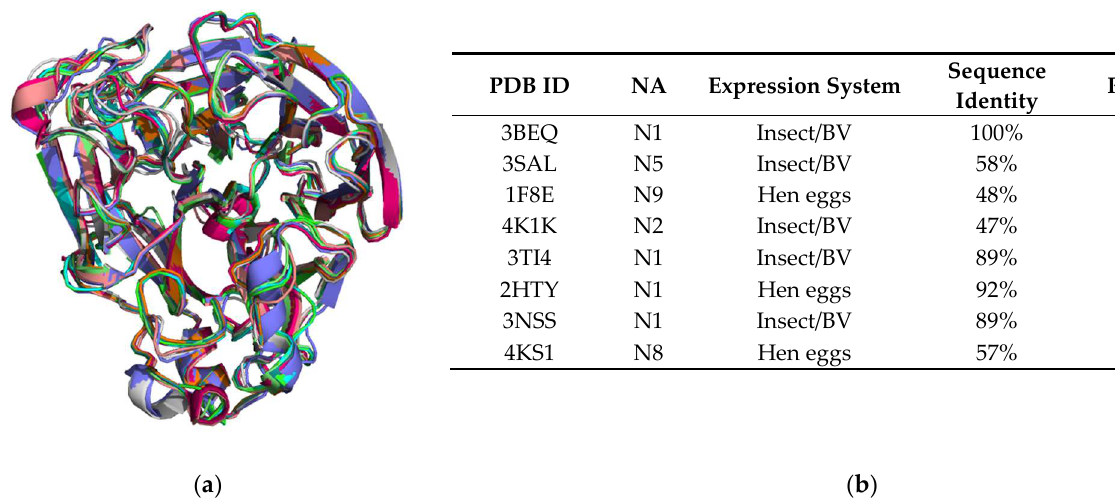
Figure 6. Overall structural comparison with other NA structures. ( a ) Structural alignment of NA monomers from various influenza virus strains and expression systems. Lime green: HEK NA, A/BrevigMission/1/1918 (H1N1). Cyan: 3BEQ, A/BrevigMission/1/1918 (H1N1). Light pink: 3SAL, A/duck/Alberta/60/1976 (H12N5). Grey: 1F8E, A/tern/Australia/G70C/1975 (H11N9). Purple: 4K1K, A/RI/5+/1957 (H2N2). Orange: 3TI4, A/California/04/2009 (H1N1). Dark Green: 2HTY, A/Vietnam/1203/04 (H5N1). Teal: 3NSS, A/California/04/2009 (H1N1). Hot pink: 4KS1, A/duck/Ukraine/1/1963 (H3N8). Chain A from each structure was chosen for the alignment. This superposition was performed in PyMOL, using the align command, which performs a sequence alignment, followed by a structural superposition. Water, metal ions and ligands were excluded from the alignment. A side-by-side comparison of HEK NA and 3BEQ can be seen in Supplemental Figure 2. ( b ) Differences between NA structures produced using HEK293-6E cells as compared to selected NA structures within the PDB. RMS differences were calculated in PyMOL, using the align command after exclusion of water, metal ions and ligands.